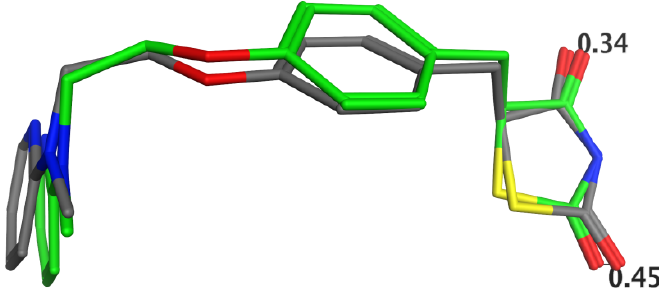
Figure 3. Superposed structures of rosiglitazone: the X-ray structure (PDB ID 1FM6) is shown in the atom type colour and the carbon atoms of the structure optimised by the MMFF94s force field are coloured in green. The structures are superposed on the heteroatoms, and the distances between the oxygen atoms in the thiazolidine ring are in